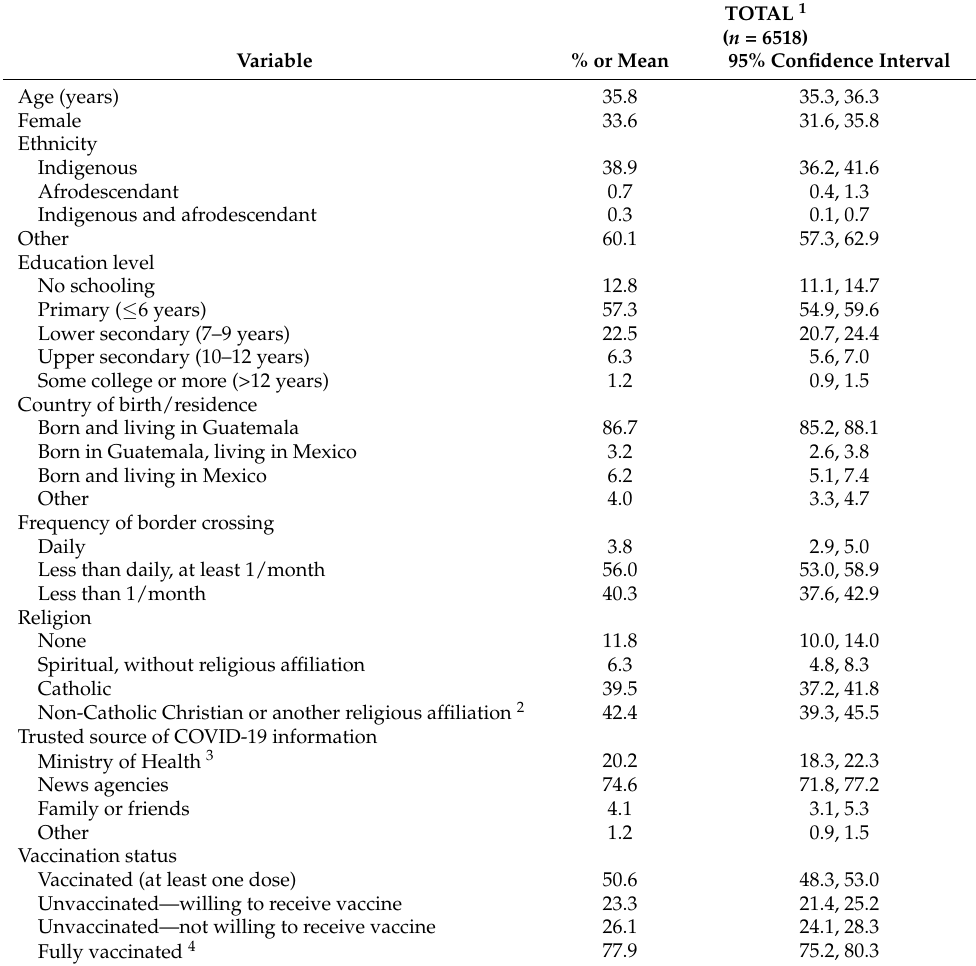
Table 1. Sociodemographic and vaccine-related characteristics of participants, survey of transborder populations at the Mexico–Guatemala